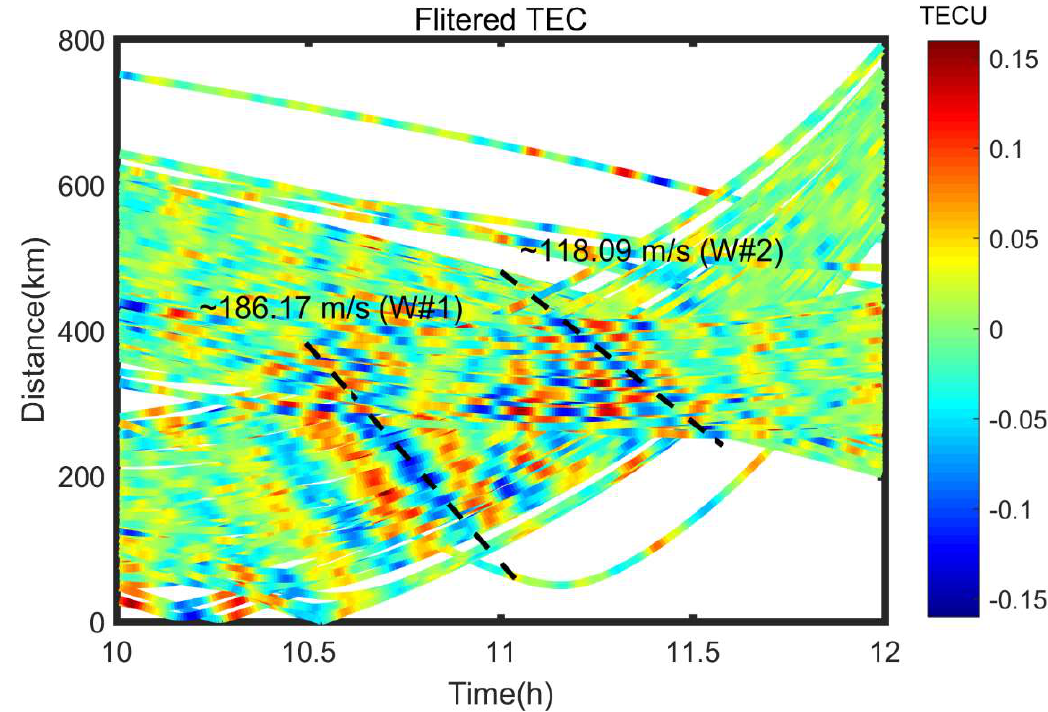
Figure 7. A graph of filtered TEC with the time. The dashed black line indicates the fitted perturbation propagation speed, and the colored bars indicates the magnitude of the VTEC disturbance.